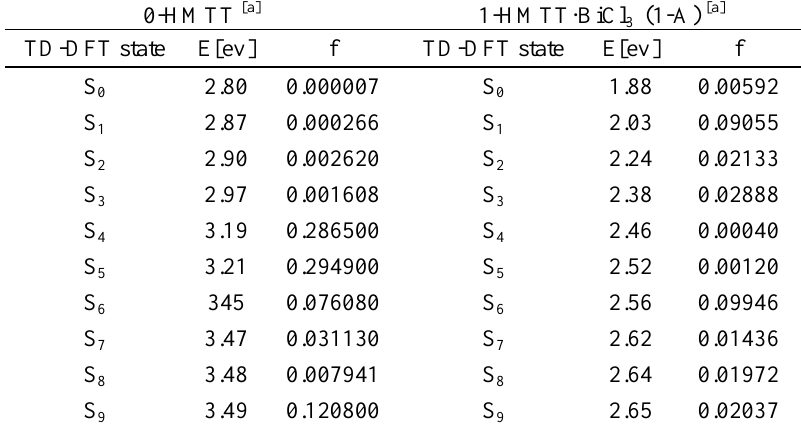
Table 3. TDDFT calculation of excitation energies (E) and oscillator strengths (f) of the lowest excited singlet-singlet